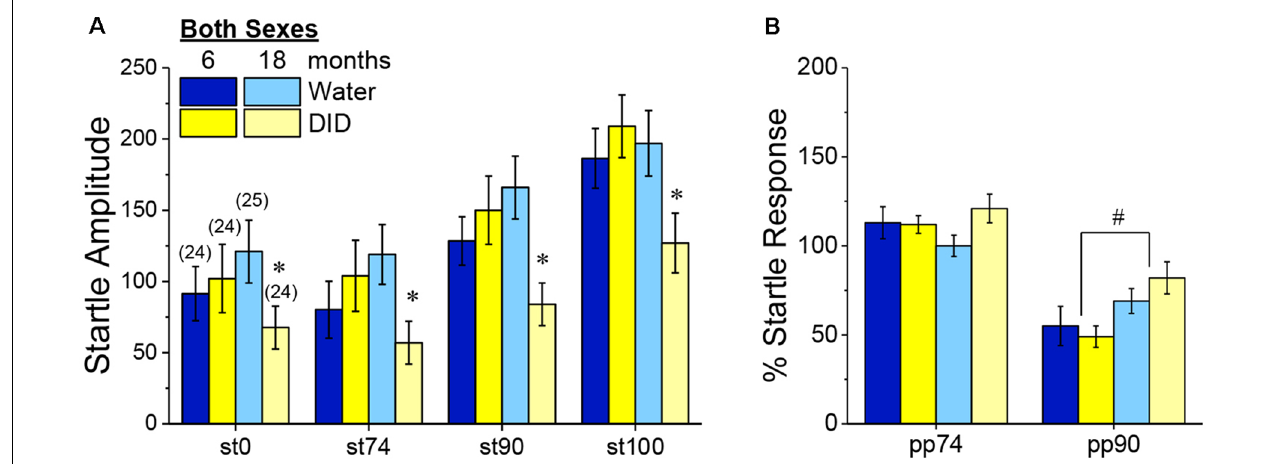
FIGURE 9 | Effects of binge drinking during later maturity (6 months of age) or old age (18 months of age) on acoustic startle in isogenic C57BL/6J mice. (A) Relative to water-drinking controls (Water), binge drinking (DID) 18-month-old mice exhibited lower acoustic startle, with no binge drinking effect apparent in 6-month-old mice. (B) Only the 90 dB prepulse inhibited acoustic startle and the extent of this inhibition was larger in 6 vs. 18-month-old mice, with no effect of binge drinking detected for the acoustic startle. The data represent the means ± SEMs of the number of mice indicated in parentheses in Panel (A) . ∗ p < 0.05 DID vs. Water; # p < 0.05 6 vs. 18 months